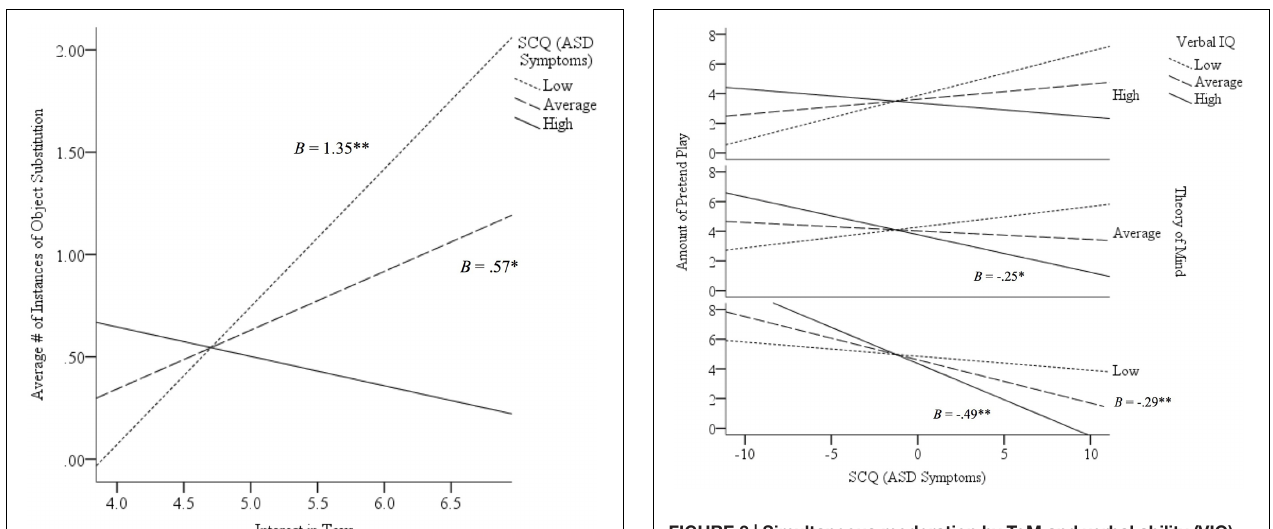
FIGURE 3 | Simultaneous moderation by ToM and verbal ability (VIQ) on the relation between ASD symptoms and pretend play. More ASD symptoms related to less pretend play production when ToM was low and VIQ was average or high, and when ToM was average and VIQ was high. All other relations were non-significant. The negative relation between ASD symptoms and pretend play was especially pronounced among those with low ToM and high verbal ability. * p < 0.05, ** p < 0.01. Low = 1 SD below sample mean. Average = sample mean. High = 1 SD above sample